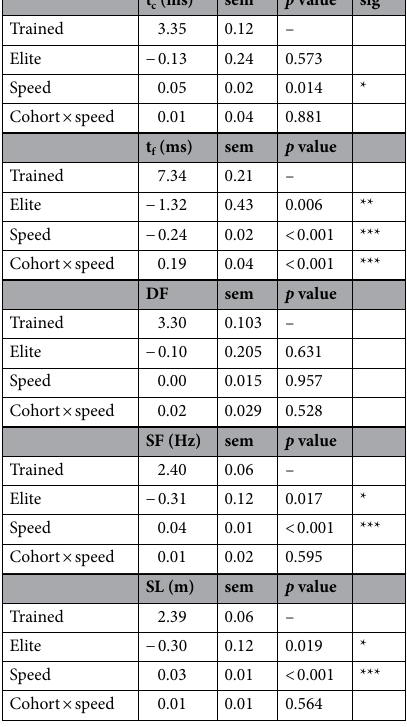
Table 4. Coefficients of variation (expressed as a %) for spatiotemporal measures with effects for cohort, speed, and the interactions. The values provided for the trained cohort correspond to the model estimate at 14 km/h, with the elite difference, speed-relation (all subject change per km/h), and cohort-speed interaction presented below that. Estimated standard errors are provided for each effect 68 . Statistical significance of each effect is indicated as: * p < 0.05, ** p < 0.01, and *** p <